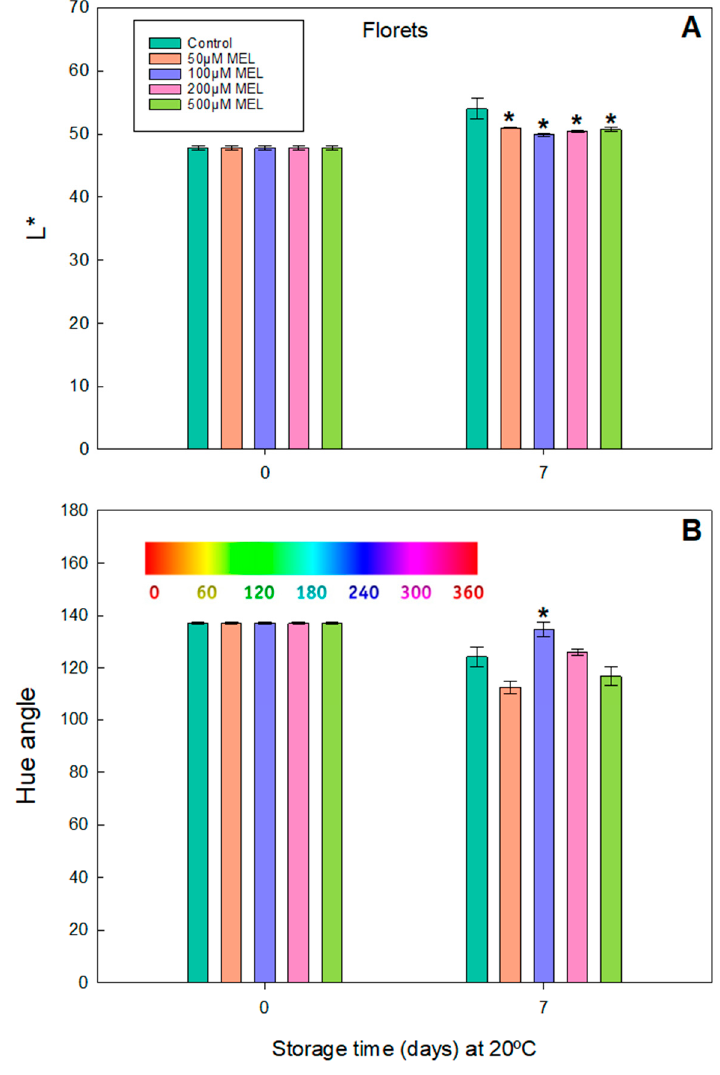
Figure 1. Color parameters in broccoli florets stored at 20 °C. ( A ) Luminosity (L*) and ( B ) Hue angle of broccoli florets treated with 50, 100, 200 and 500 μ M of melatonin and stored in the dark at 20 °C for 0 and 7 days. Each bar represents the mean value ± standard error ( n = 3) obtained for each concentration used. Asterisks indicate significant differences with the control of that day based on a Tukey HSD test with a significance level of p < 0.05. In ( B ), the Hue angle scale has been incorporated as a color guide.